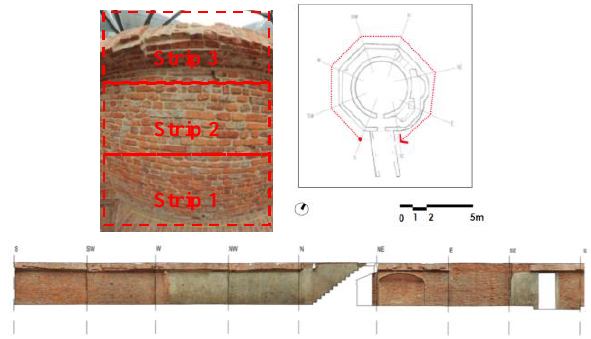
Fig. 5. Example of image acquired with the fisheye lens (top- left); the line along which orthphotos were generated (top- right); and final orthophoto of the narrow corridor developed along a stright line